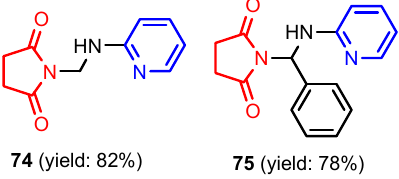
Figure 5. Structure of Mannich pyrol-pyridine bases 74 and 75 [36]. Angelova et al. [37] reported the synthesis of two pyridine-indole compounds 76a and 76b by condensation of nicotinohydrazide with 5-methoxy-1 H -indole-3-carbaldehyde or 5-bromo-1 H -indole-3-carbaldehyde in an ethanol solution, and evaluated their in vitro antibacterial activity against M. tuberculosis H37Rv (MIC = 1.6989 µ M and 2.9139 µ M respectively) using isoniazide and ethambutol as reference drugs (Scheme 13). Abo-Salem et al. [38] synthesized a new class of bis(indolyl)pyridines 77 analogues of the marine alkaloid nortopsentin in good yields (75–96%), using a one-pot four-component condensation of 3-cyanocarbomethylindole, various aldehydes, 3-acetylindole, and ammonium acetate in glacial acetic acid. Moreover, 2,6-bis(1 H -indol-3-yl)-4-(benzofuran) pyridine-5-carbonitriles 78 were synthesized via a one-pot four-component condensation of 3-cyanocarbomethyl indole, 2-acetylbenzofuran, N-substituted-indole-3-aldehydes and ammonium acetate (Scheme 14). Four compounds— 77b , 78a , 78c , and 78d —demonstrated good antimicrobial activity against S. aureus , E. coli ., and C. albicans , as can be seen in Table 3. All antimicrobial active compounds studied ( 77b , 78a , 78c , and 78d ) revealed favorable binding interactions and binding energy with the binding site of thymidylate kinase (ID: 4QGG) with values ranging from − 15.52 to − 25.36 kcal mol − 1 , which is comparable to the native ligand of − 24.34 kcal mol − 1 . Figure 6 revealed the binding mode of the re-docked 78d within the binding pocket of TMPK (Thymidylate kinase, ID: 4QGG). The structures of Thymidylate kinase (TMPK), DNA gyrase subunit B, and DNA topoisomerase IV subunit B were retrieved from the protein data bank at http://www.rscb.org./pdb (accessed on 1 May 2022) using 4QGG, 6F86, 4HZ5 codes, respectively, and a Gaussian Contact surface around the binding sites were drawn using MOE 2008.10 (Molecular Operating Environment, http://www.chemcomp.com (accessed on 1 May 2022). Mabkhot et al. [39] reported synthesis of thiophene-pyridine compound 80 by reaction of the enaminone 79 (Scheme 15). The presence of the pyridine nucleus has been shown to be necessary for better antifungal activity than Amphotericin B (standard) against Aspergillus fumigates and Syncephalastrum racemosum. Moreover, compound 80 revealed a moderate activity towards Geotricum candidum and Candida albicans. Flefel et al. [40] reported the